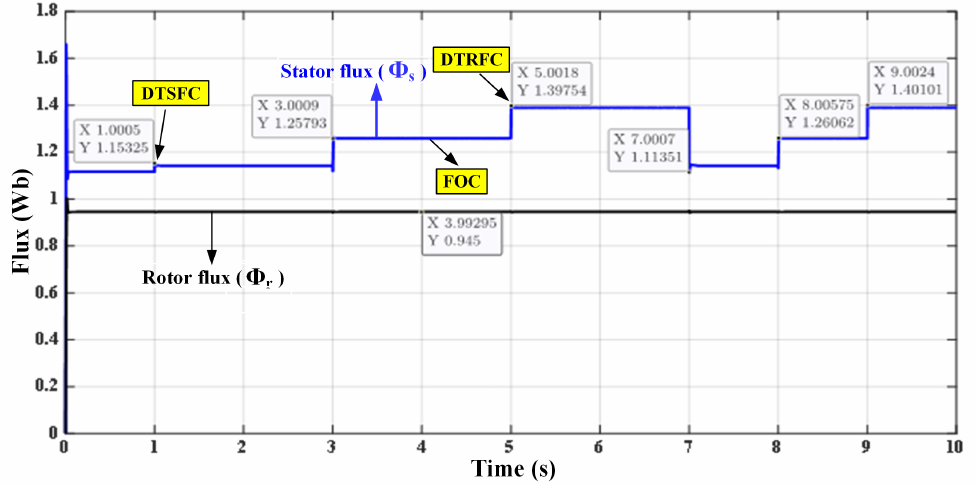
Figure 31. Stator and rotor fluxes responses in the proposed FOC-DTC over a wide torque